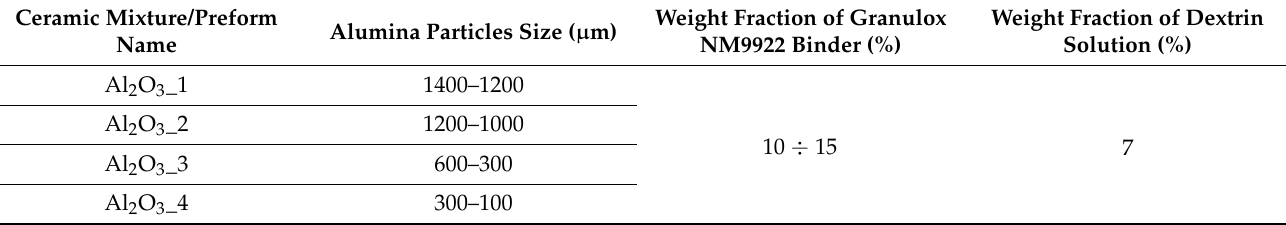
Table 1. Composition of the ceramic mixture used for the fabrication of forms. Ceramic